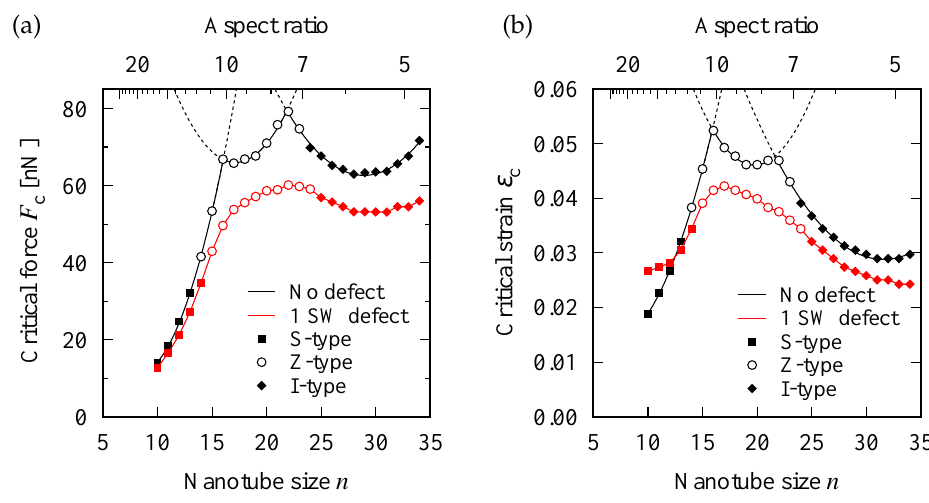
Figure 3. Tube diameter-driven modulations in: ( a ) the critical buckling force F c , and ( b ) critical buckling strain ε c . The presence/absence of a SW defect and the buckling mode occurred are distinguished by differences in colors and symbols, respectively. The curve profile with two cusps in the data of the defect-free models is fitted with three parabolas each (solid and dashed lines), which are corresponding to the S, Z, and I buckling